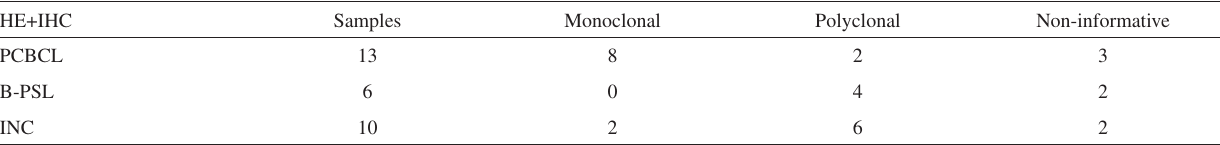
Table 4 - Summary of clonality analysis results of the 29 cases with B-cell lymphoproliferative